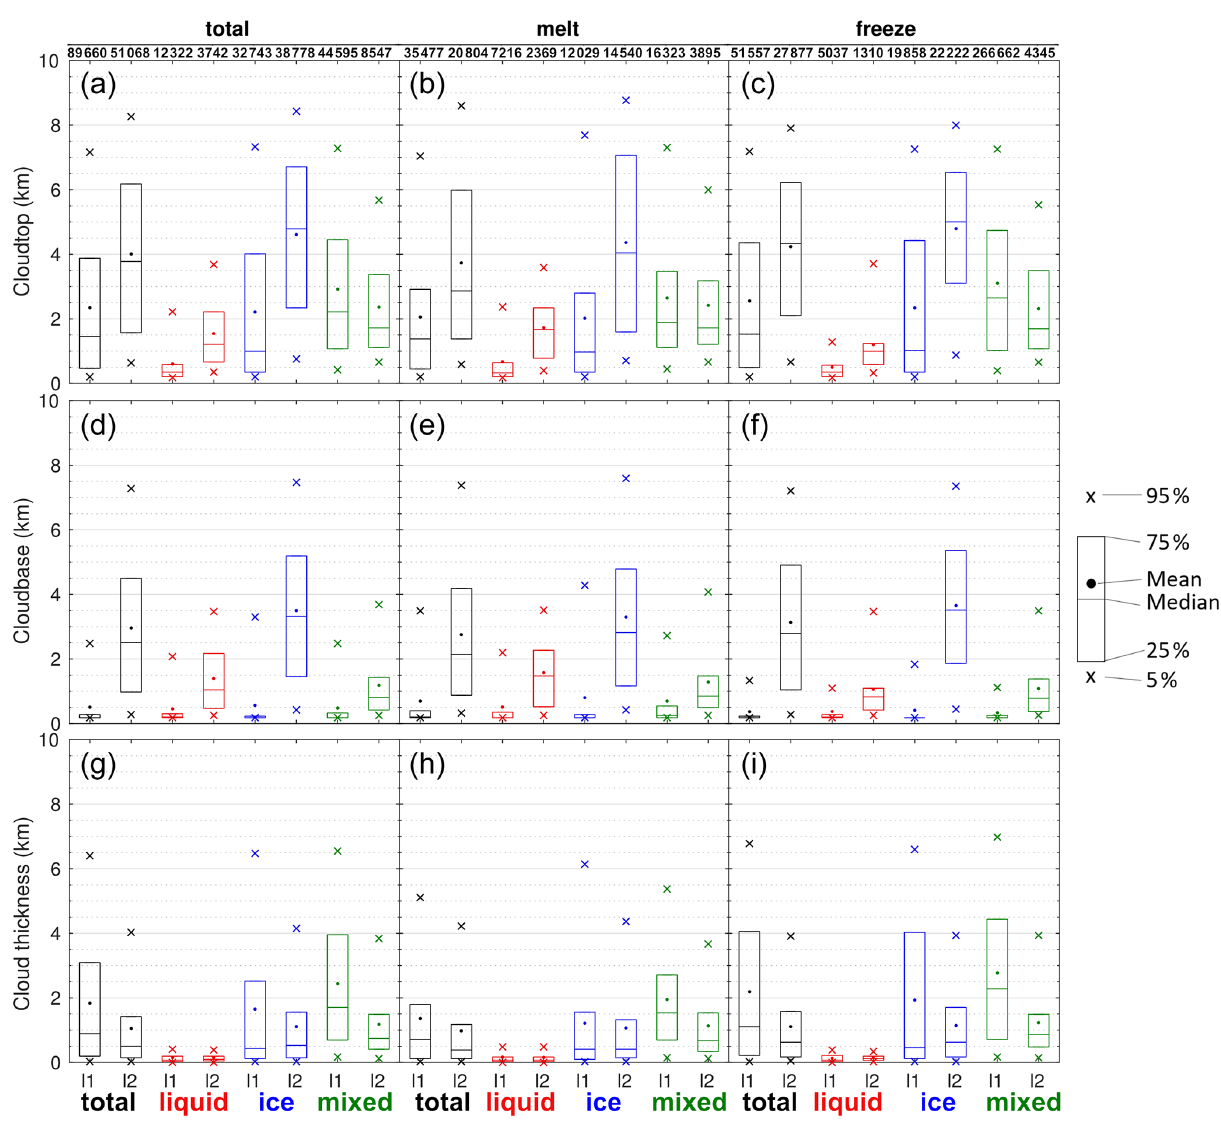
Figure 12. Statistical overview of cloud top height (a–c) , cloud base height (d–f) , and geometrical thickness (g–i) for the entire AO2018 campaign (a, d, g) as well as for melt (b, e, h) and freeze (g, h, i) conditions. The colours indicate different cloud types. Results for the lowest two cloud layers (l1 and l2) are shown. The top row shows the number of profiles used for each